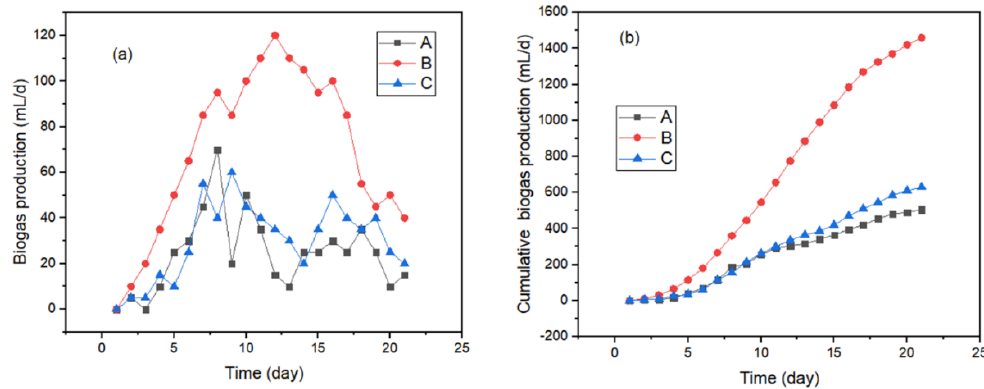
Figure 6. ( a ) Daily and ( b ) cumulative biogas production; B—Ms (red) > C—Control (blue) > A—Alum (black).